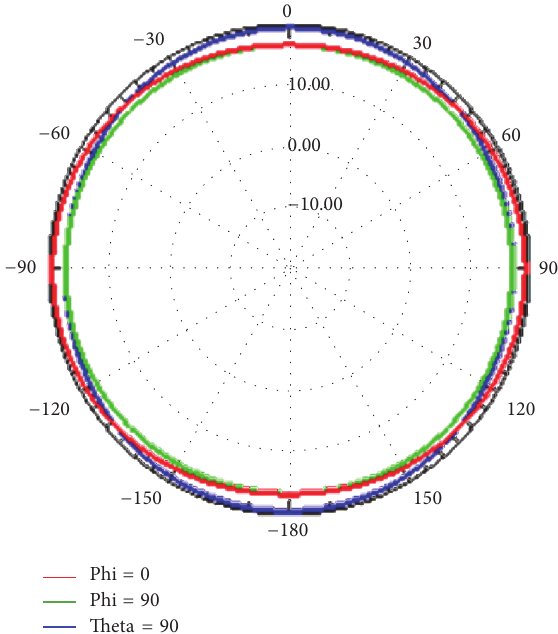
Figure 27: Radiation patterns ( 𝐸 total ) in 2D of 3D spherical antenna (Table 10) in the plans: 𝑥𝑧 , 𝑦𝑧 , and 𝑥𝑦 .